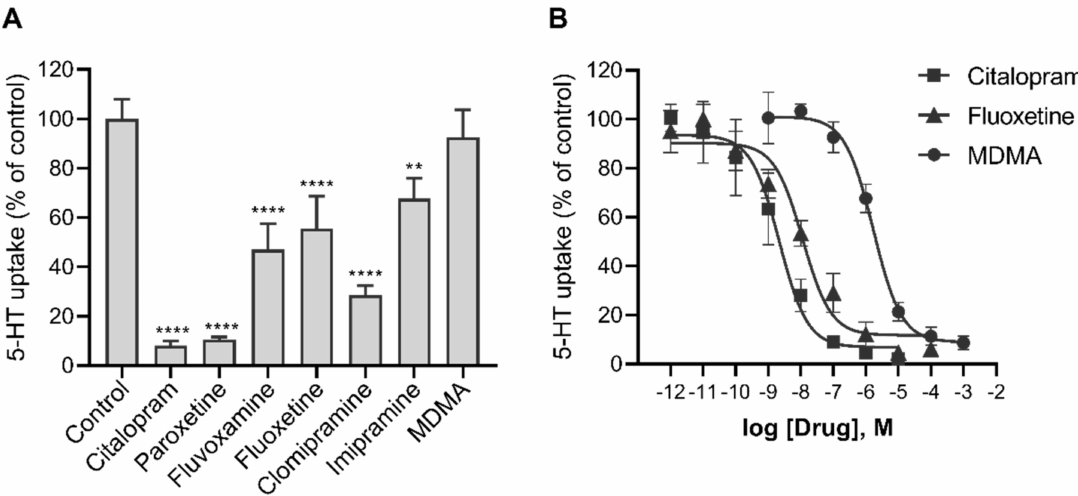
Figure 6. The potency of various psychotropic drugs to inhibit the uptake of 5-HT into human primary trophoblasts. Cells were incubated for 10 min in the presence of radiolabeled 5-HT (10 − 7 M) and ( A ) 10 − 7 M or ( B ) increasing the concentrations of the indicated drugs. Values are expressed as a percentage of control (vehicle without the drug). The best-fit half-maximal inhibitory concentrations (IC 50 ) of citalopram, fluoxetine, and MDMA were 2, 11, and 1678 nM, respectively, with 95% confidence intervals (CI) of 1 to 7 nM, 4 to 33 nM and 1045 to 2745 nM, respectively. All data are the means ± SEM of three separate experiments, each performed in triplicate. Cells from different donors were used to generate the data shown in panels A and B; the values for fluoxetine in panel A (44%) are not statistically different from the values for 10 − 7 M fluoxetine in panel B (29%). ** p < 0.01, **** p < 0.0001 for comparison with control (Dunnett’s test after one-way ANOVA, F 7,16 = 52.34, p < 0.0001).